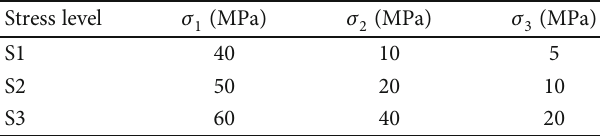
PFC simulation. Table 3: Initial stress